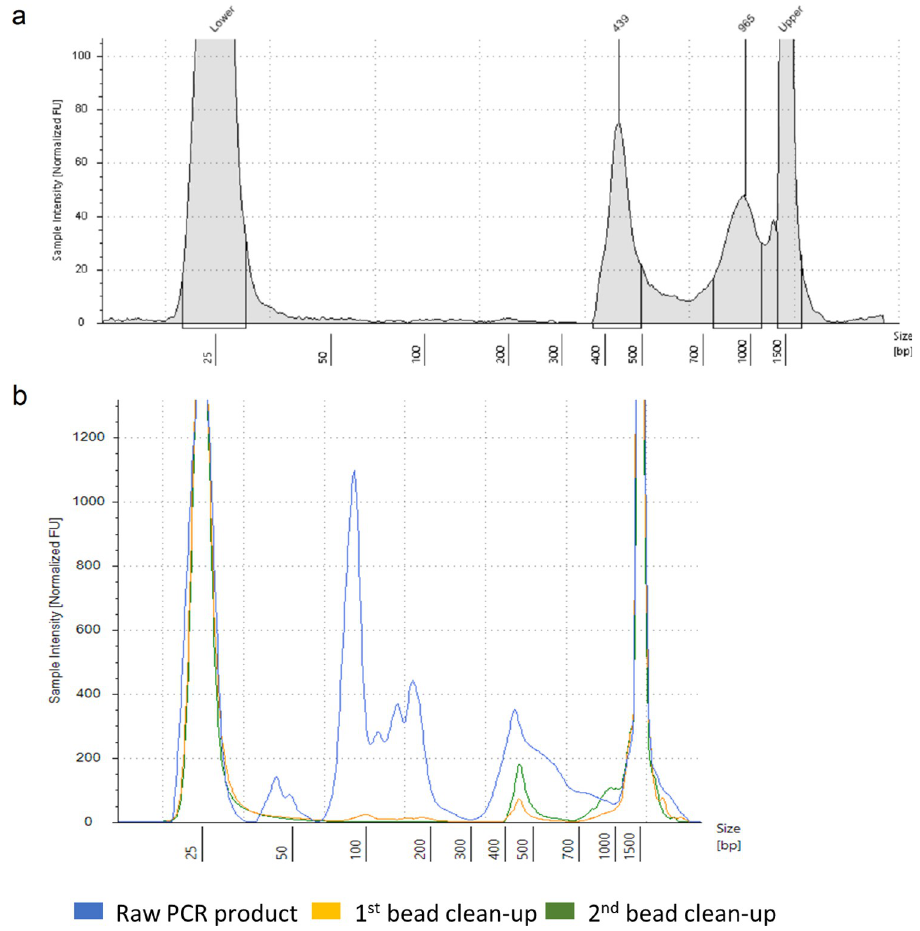
Fig 3. Library quality control using fragment size analysis demonstrated importance of two post-PCR clean-up steps. (a) Typical size profile from Agilent D1000 ScreenTape assay of a wastewater sequencing library following post- PCR clean-up and (b) overlayed electropherograms showing size profiles of raw PCR products and after 2 consecutive bead clean-up steps.